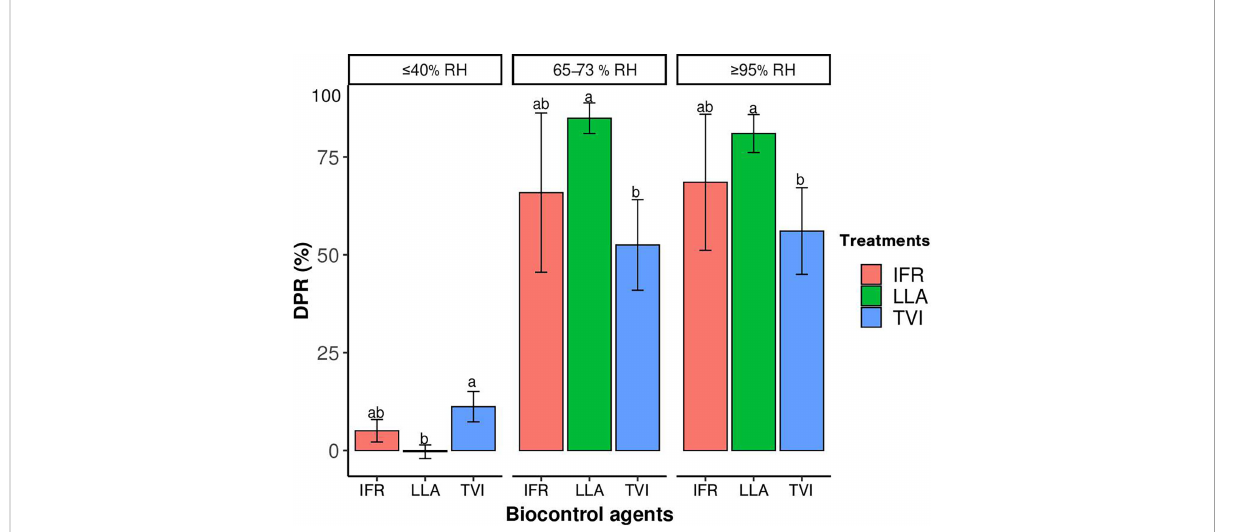
FIGURE 5 The ef fi cacy of the BCAs: Lecanicillium attenuatum (LLA), Isaria fumosorosea (IFR), and Trichoderma virens (TVI) measured by disease reduction percentage (DPR) of powdery mildew pathogen, Podosphaera xanthii , on cucumber leave grown for 20 days under different relative humidity conditions. The vertical bars are the mean ± SE (n = 6). The different letters indicate that values are signi fi cantly different at P< 0.05 according to the Least Signi fi cance Difference test.